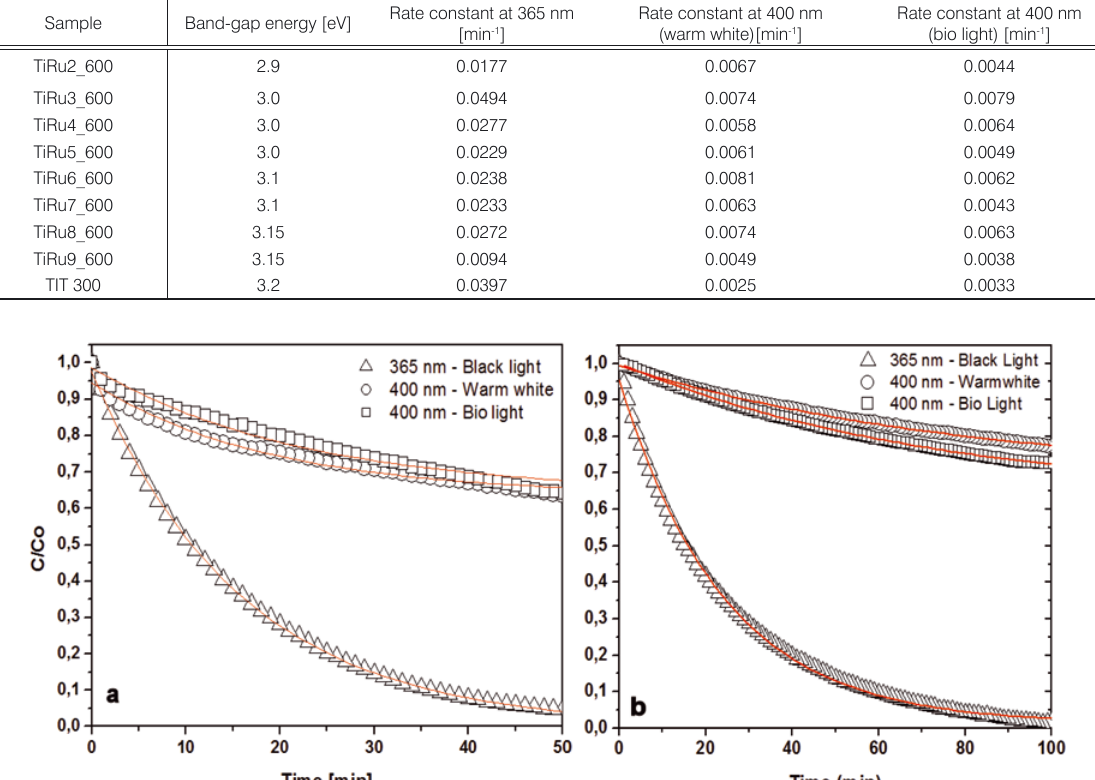
Table 3. Band-gap energies and rate constants of the Ru-doped titania samples. Sample